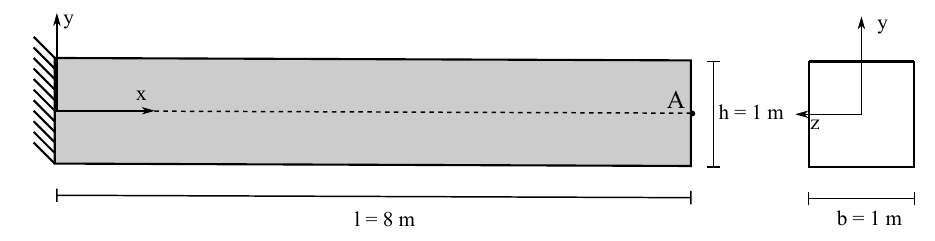
Figure 4. Static 2D cantilever analysis: